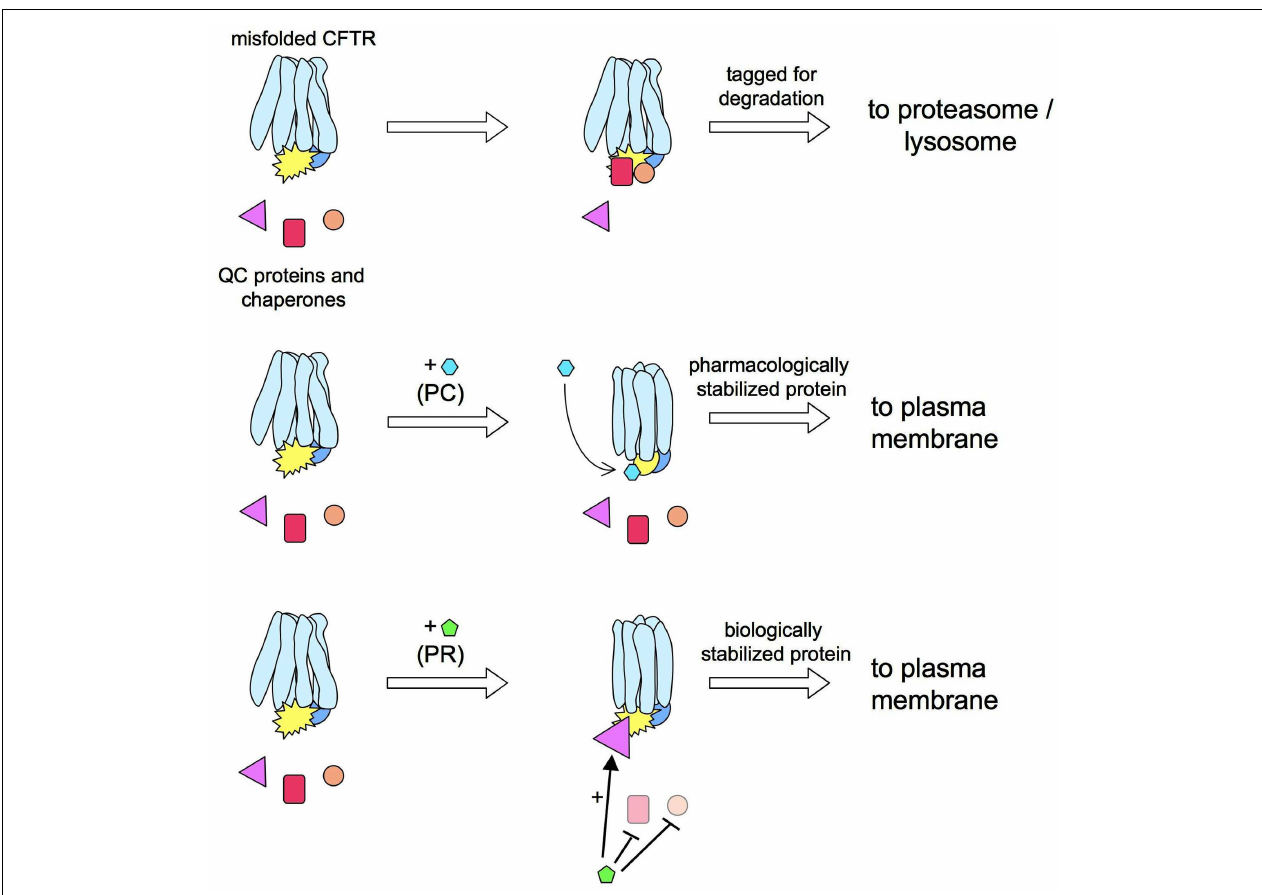
control (QC) proteins thus allowing more protein in the plasma membrane (PM). An alternative approach for ∆ F508-CFTR is the use of a proteostasis regulator (PR).These compounds act by globally changing the proteome, or a more restricted group of proteins, to create an environment more benign toward mutant